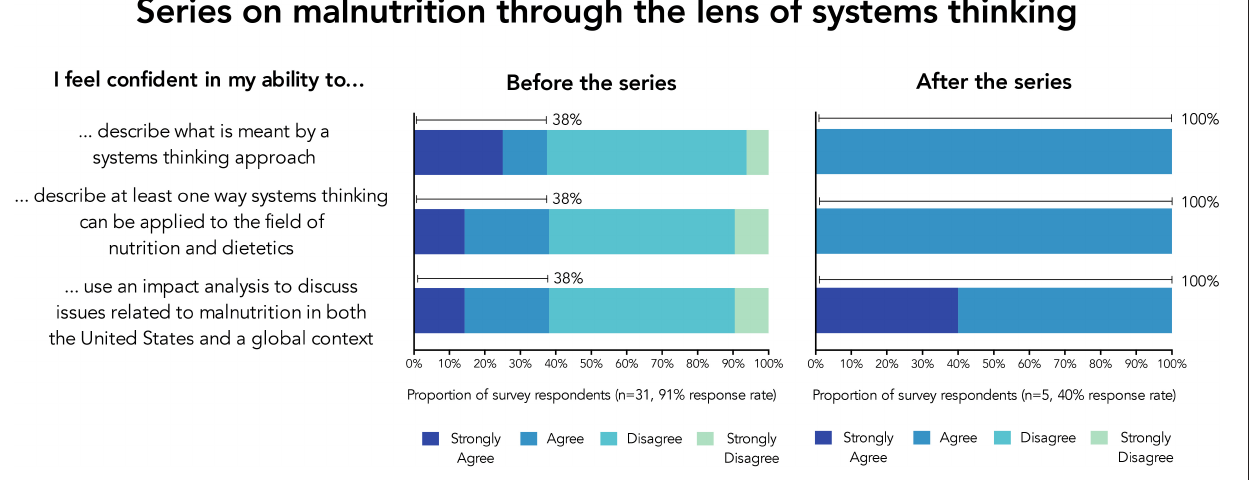
FIGURE 2 | Survey results before and after participation in interactive webinar series. The values above the bars show the sum of “strongly agree” and “agree” responses. In addition to participants’ self-reported confidence in learning outcomes (shown here), the surveys also asked about what participants hoped to learn (pre-survey) and ideas for improving the series (post-survey); full survey instruments are available in Appendix A ( Supplementary Material ), and numerical values for the proportions shown in this figure are available in Appendix B ( Supplementary Material